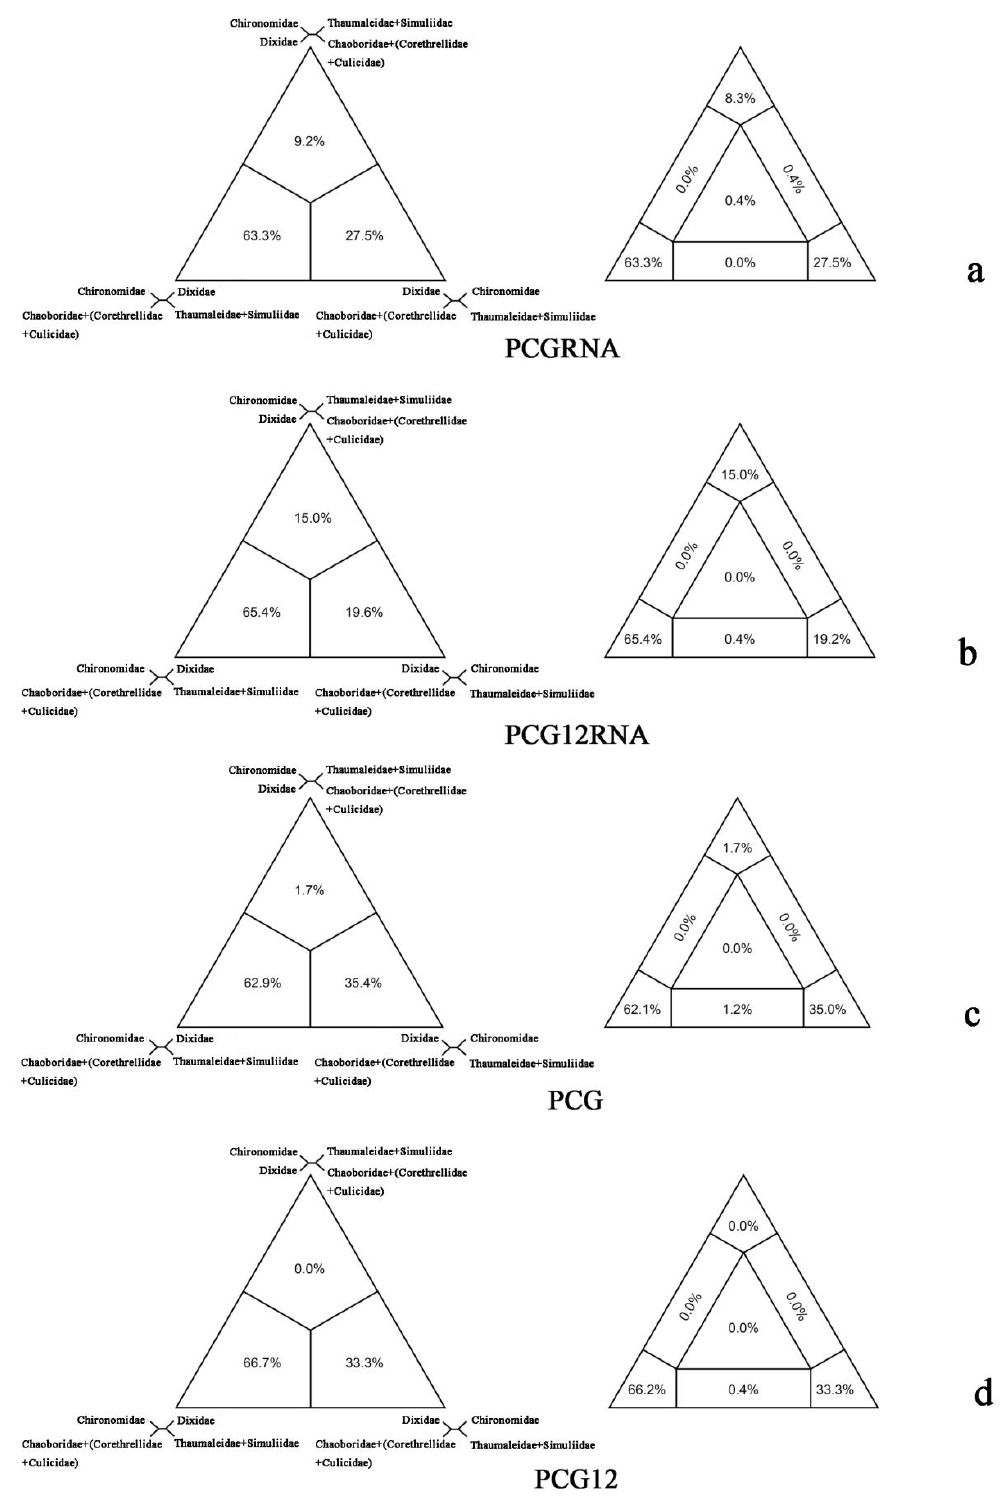
Figure 3. Results of Four-cluster Likelihood Mapping as 2D simplex graphs. ( a ) Four-cluster Likelihood Mapping based on PCGRNA; ( b ) four-cluster Likelihood Mapping based on PCG12RNA; ( c ) four-cluster Likelihood Mapping based on PCG; ( d ) four-cluster Likelihood Mapping based on PCG12.